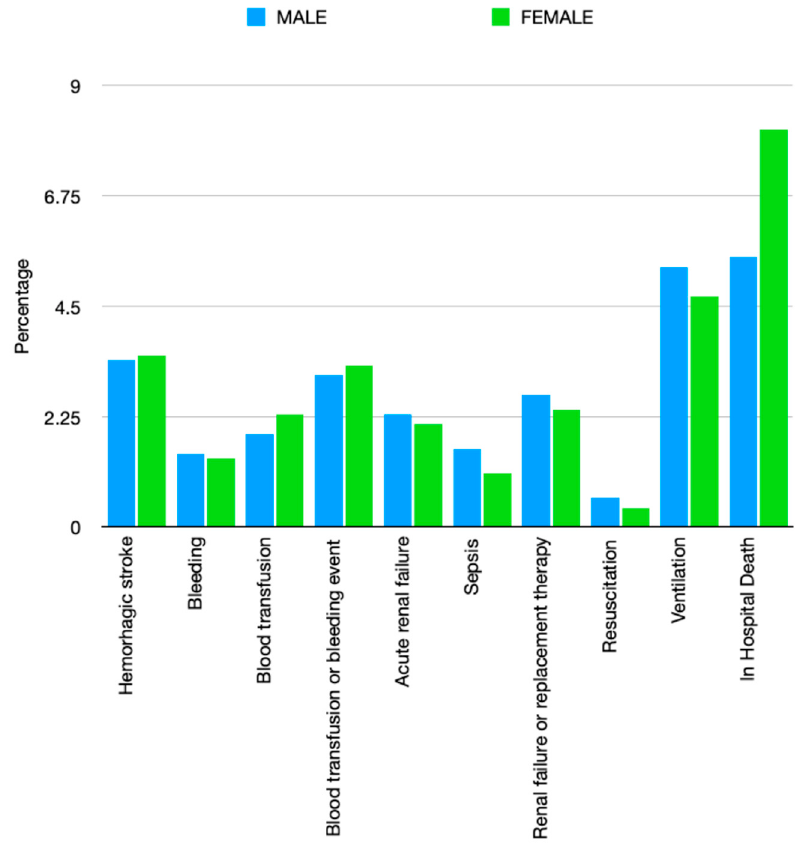
Figure 1. In-patient hospital complication and mortality rate female sex versus male sex. The bar plot shows that the number of in-patient hospital complication was increased in men as compared to women, while mortality, on the other hand, was higher in women.